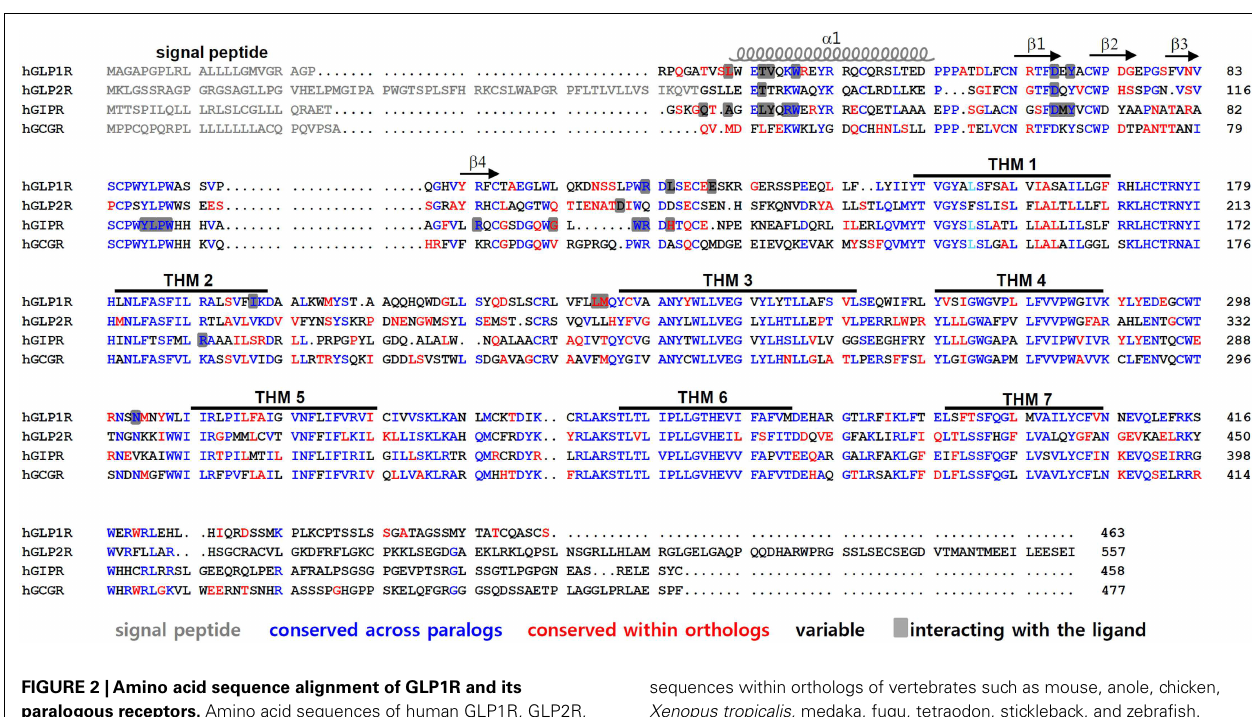
FIGURE 2 |Amino acid sequence alignment of GLP1R and its paralogous receptors. Amino acid sequences of human GLP1R, GLP2R, GCGR, and GIPR are compared.The signal peptides are indicated in gray. The residues colored in blue represent conserved sequences across the GLP-1-related peptide receptors. Residues in red are conserved